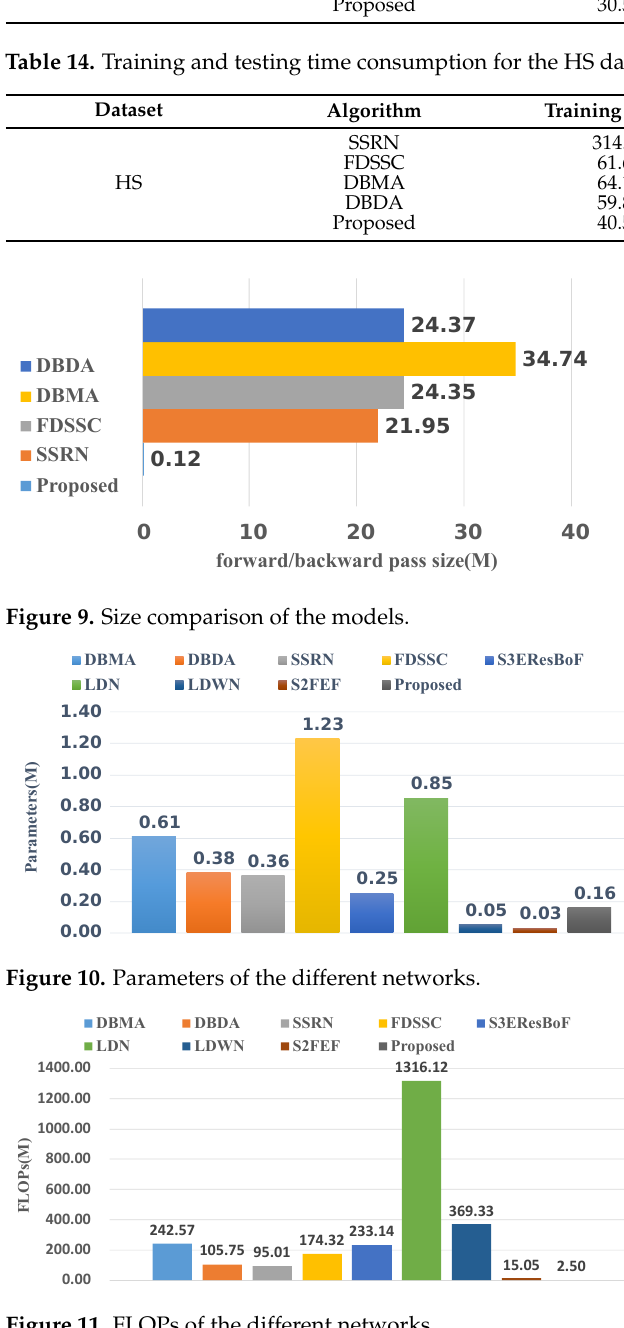
Figure 11. FLOPs of the different